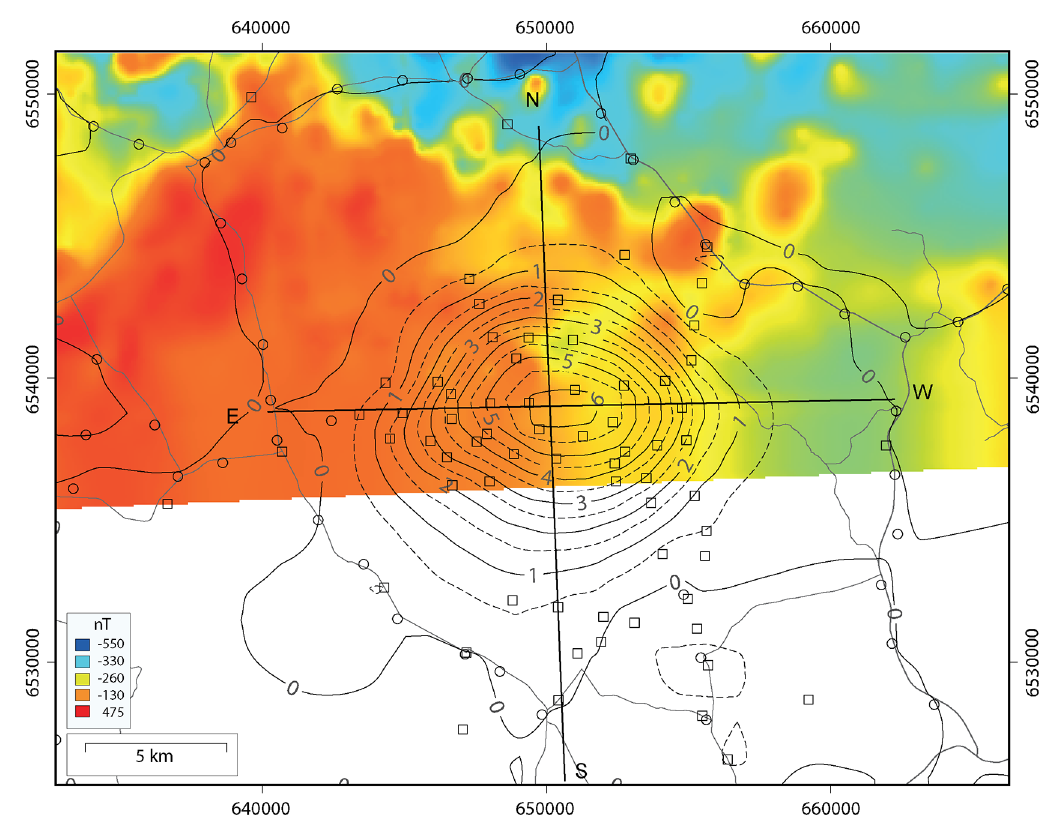
Fig. 2. Aeromagnetic map (1:25 000, Melitskaya & Papko 1992) covering the northern part of the Luusika area but without resolving a magnetic field anomaly; the gravity (Bouguer) local anomaly contours after Oja (2011) in the Luusika area; gravity points measured before 2010 (along the road network shown in the background) and in 2010–2011 are marked with circles and squares, respectively. The Estonian L-EST97 coordinate system is used for map